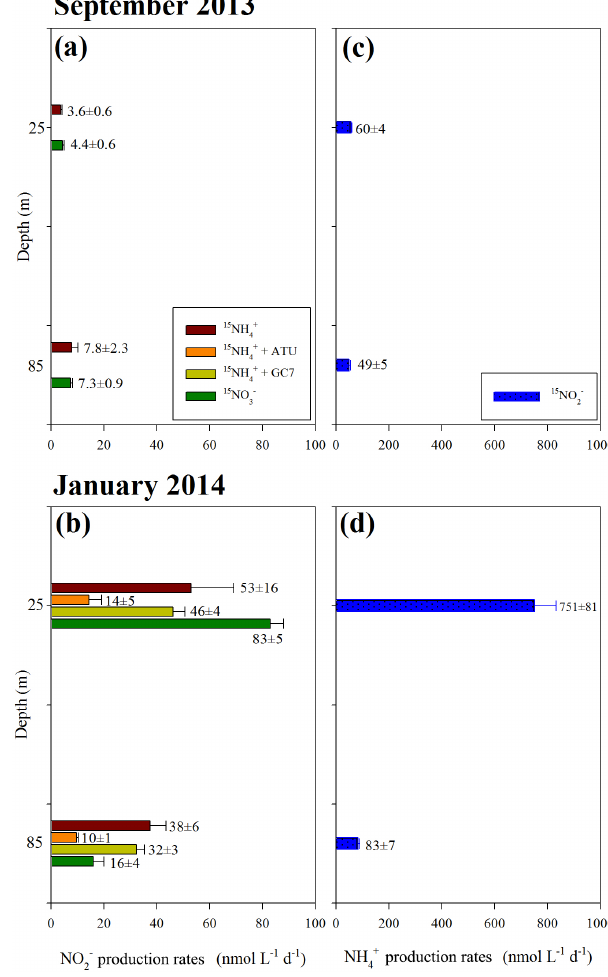
Figure 5. Nitrite (a, b) and ammonium (c, d) production rates measured as 15 N 2 after chemical conversion of the dissolved 15 N- inorganic compound produced (formed by redox reactions) mea- sured in the oxycline (25m depth) and bottom layer (85m depth) at Sta. 18 over the continental shelf off central Chile during 12 September 2013 (a, c) and 28 January 2014 (b, d) . Conventions , 15 NO − , and 4 2 ) and denote amended tracer/source ( 15 NH + , 15 NO − , and 15 NO − 4 3 2 inhibitor (ATU and GC7) that showed